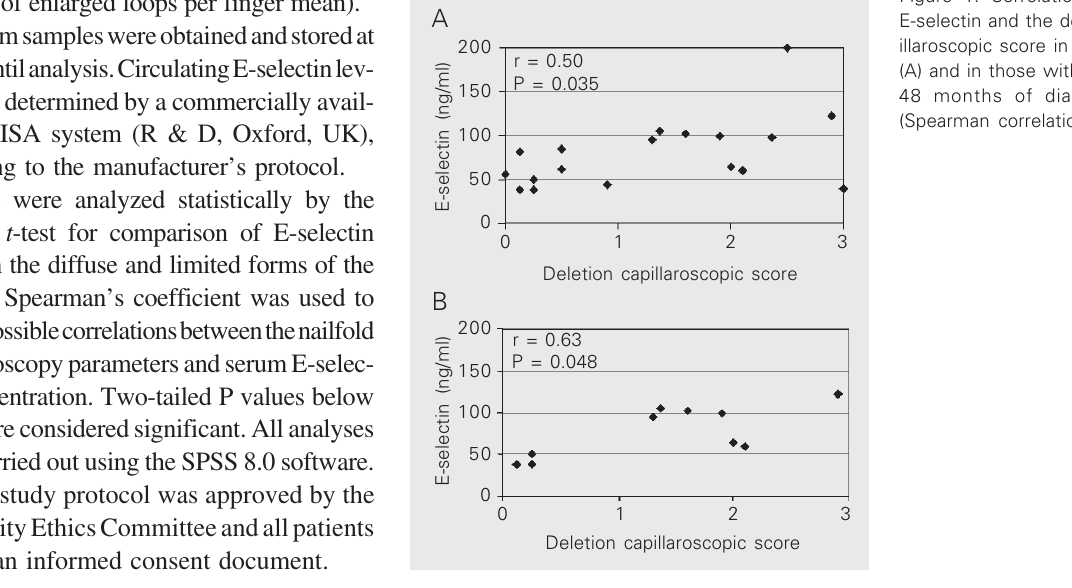
Figure 1. Correlation between E-selectin and the deletion cap- illaroscopic score in all patients (A) and in those within the first 48 months of diagnosis (B) (Spearman